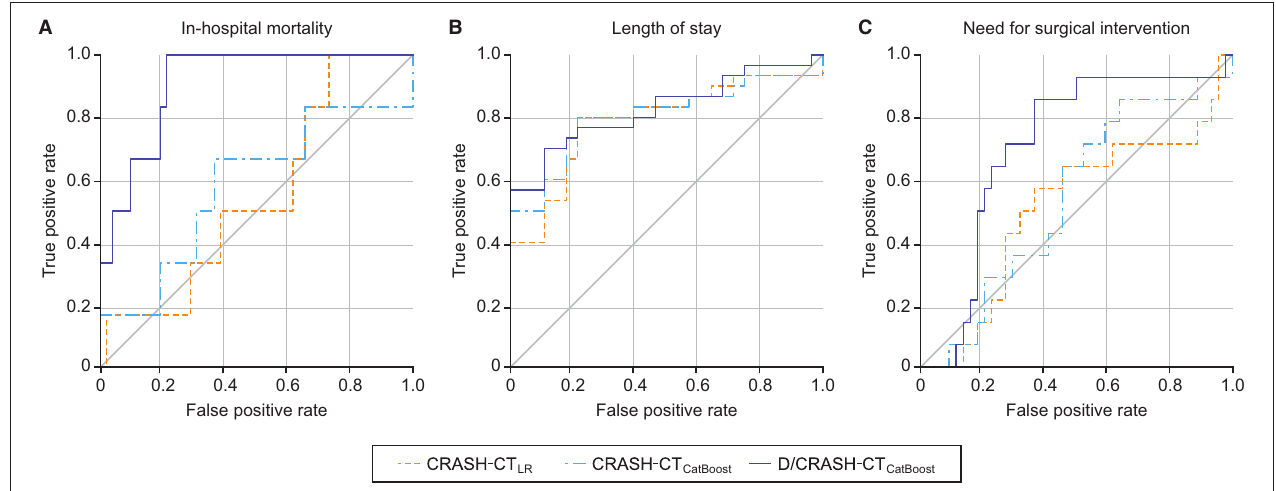
FIGURE 7 | ROC curves of the prognostic models for the differentiation of alternative outcome measures: in-hospital mortality (A) , length of stay (B) and need for surgical intervention (C) based on LOOCV. Orange = CRASH-CT LR , blue = CRASH-CT CatBoost , indigo = D/CRASH-CT CatBoost .